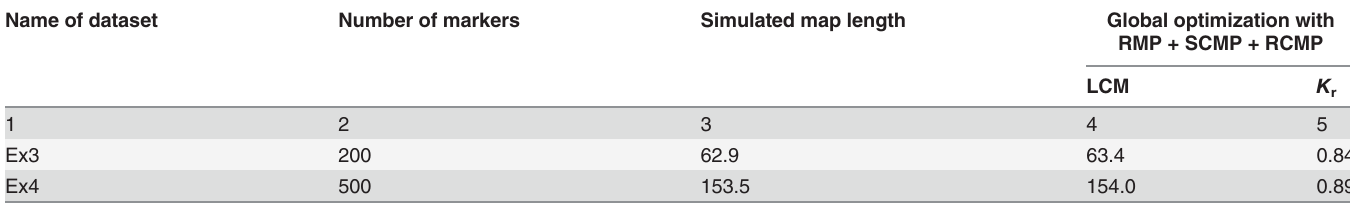
Table 3. The results of consensus mapping on the simulatedproblems of five sets by 200 and 500 shared markers. Name of